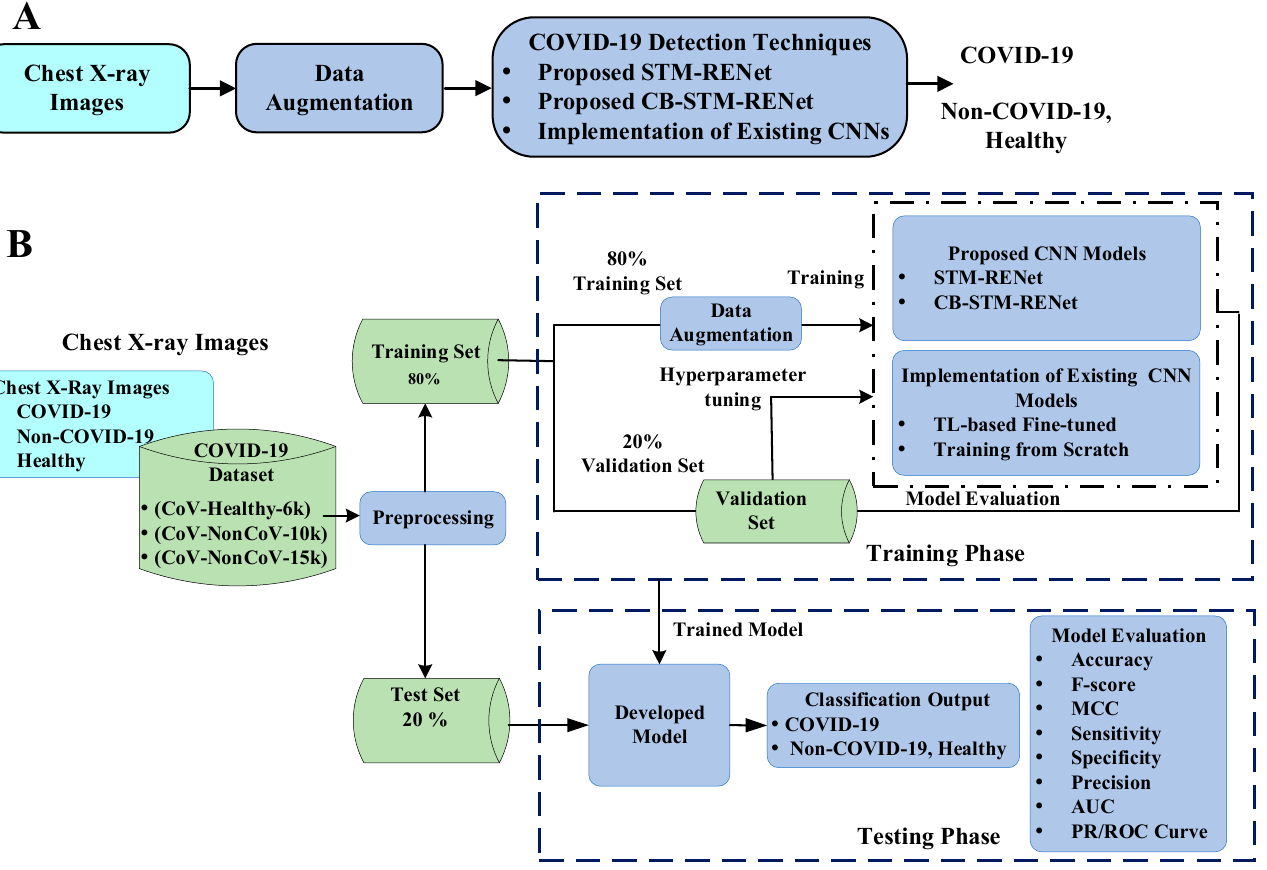
Figure 2. Panel ( A , B ) depict the brief and detailed workflow for the proposed COVID-19 detection framework, respectively.